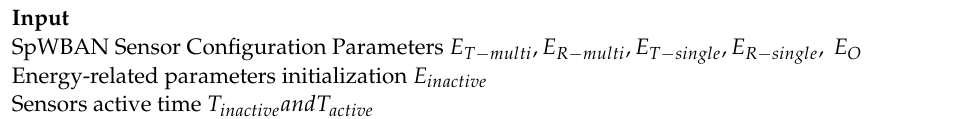
Algorithm 1 Smart Management of SpWBAN Operations by the